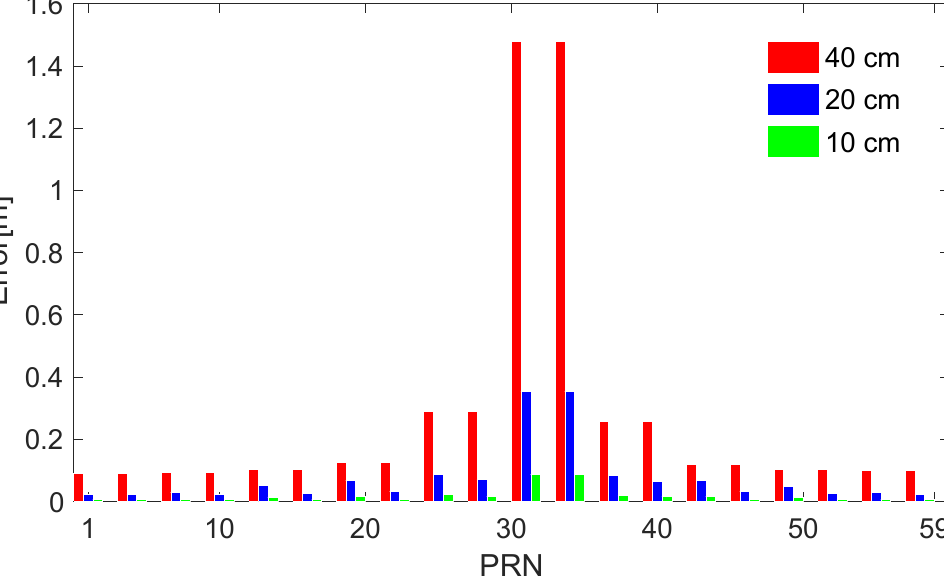
Figure 5. 60-LEO constellation orbital errors in the cross-track direction under different ranging accuracies.